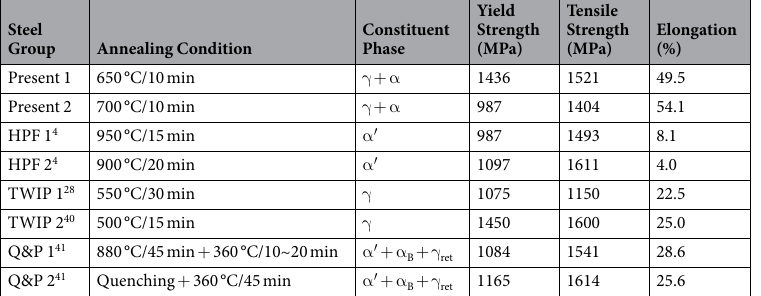
Table 1. Annealing conditions, constituent phases, and room-temperature tensile properties of ultra-high- strength